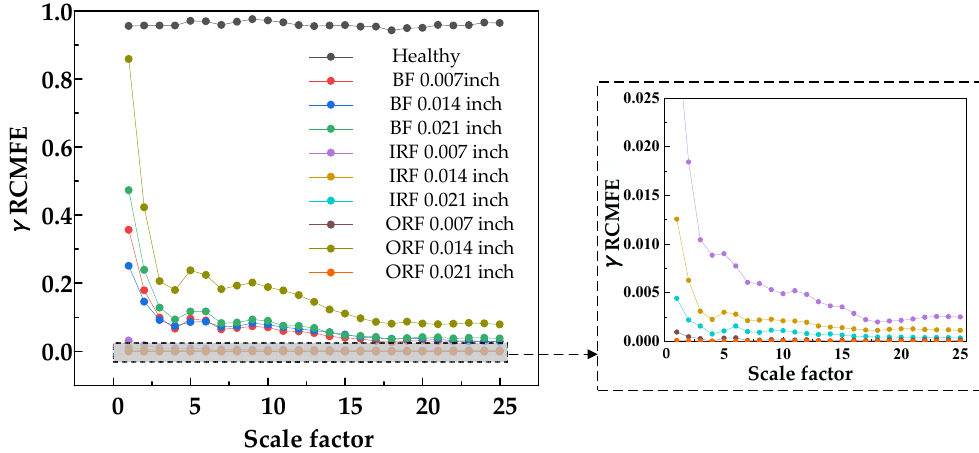
Figure 14. γ RCMFE entropy values of 25 scale factors under different damage degrees.